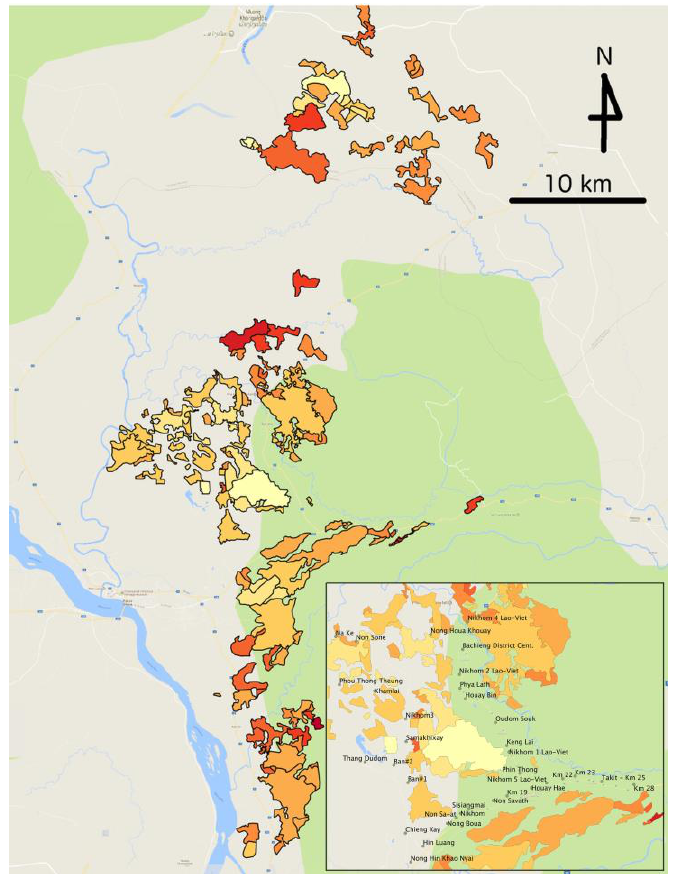
Figure 2. Location and the extent of rubber plantations in southern Laos. Shades of red to yellow indicate the year different plantations were established as identified in remotely sensed images. Also shown are the concession polygons shown in Figure 1 (thick black line) as well as major roads.